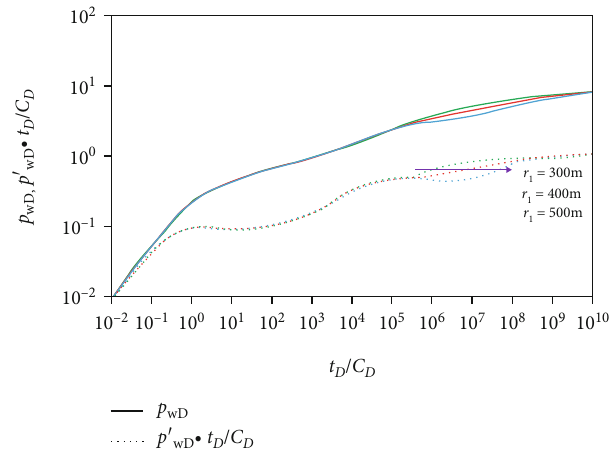
Figure 6: In fl uence of internal radius on typical pressure curves.